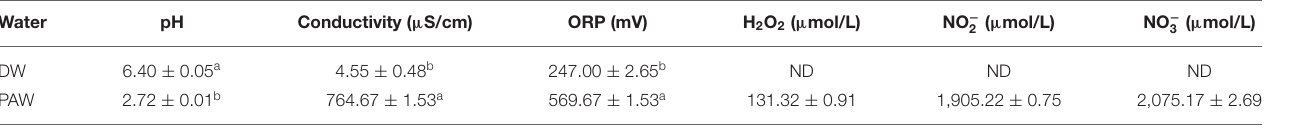
TABLE 1 | Physicochemical properties and content of active substances of distilled water (DW) and plasma-activated water (PAW). Water pH Conductivity ( µ S/cm) ORP